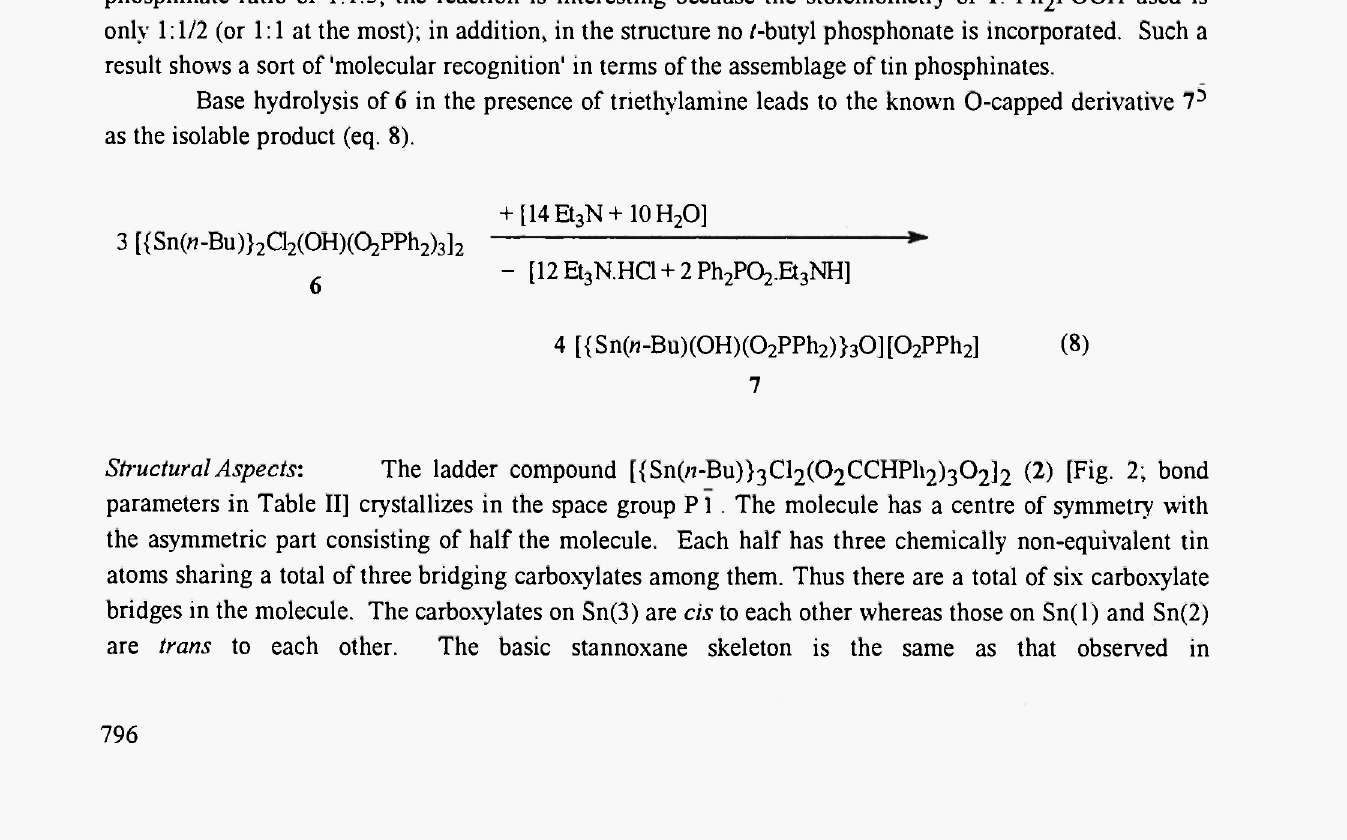
Fig. 1. The 31 Ρ and 119 Sn NMR spcctra of compound 4 (see text for more details) Since the known extended cluster [{Sn(n-Bu)(02PPh2)Cl2}{Sn(u-Bu)(0